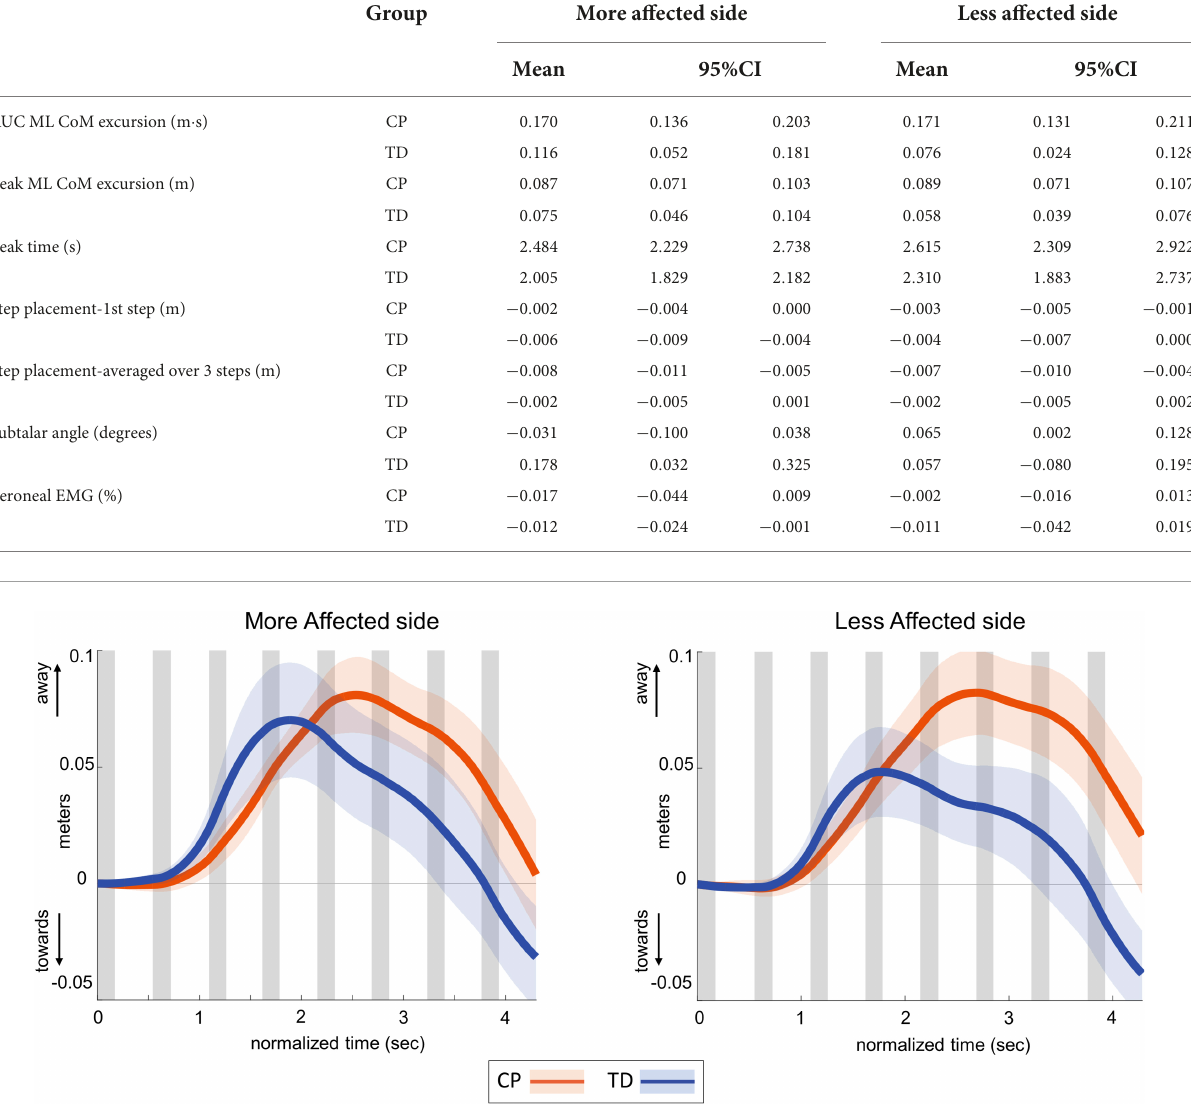
FIGURE2 Group average trajectories for medio-lateral center of mass excursion in response to visual fall stimuli in CP (orange) and TD (blue). Thick gray line along zero at X -axis indicates the mean of control (no fall stimulus) steps, which is subtracted from stimulus data. Shaded areas around each trajectory represent 95% confidence interval. X -axis shows 8 steps, time-normalized to 100 timepoints per steps, with double-stance (gray shading) and single-stance (no